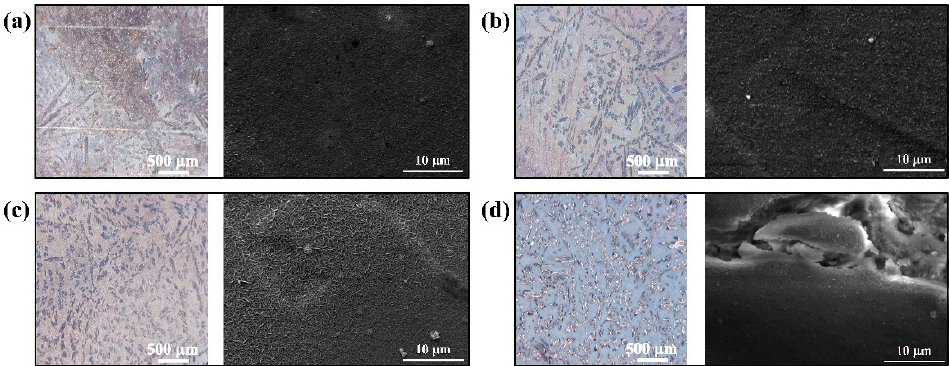
Figure 2. Macroscopic morphologies of surfaces and the corresponding microscopic morphologies of the ( a ) 120 °C-coated sample; ( b ) 130 °C-coated sample; ( c ) 140 °C-coated sample; and ( d ) 150 °C- coated sample.